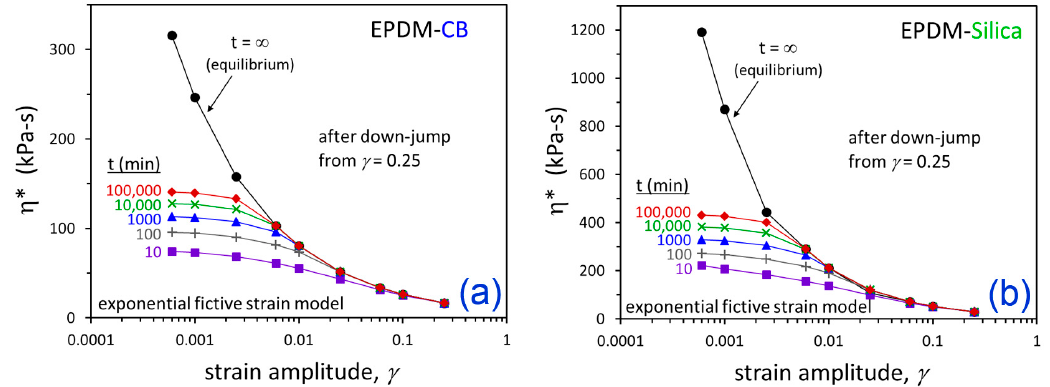
Figure 11. Predicted η * vs. γ at the indicated times for EPDM-CB ( a ) and EPDM-Silica ( b ) using parameters from fitting the experimental data (Figures 8 and 9). Note the different y-axis scalings for ( a , b ).